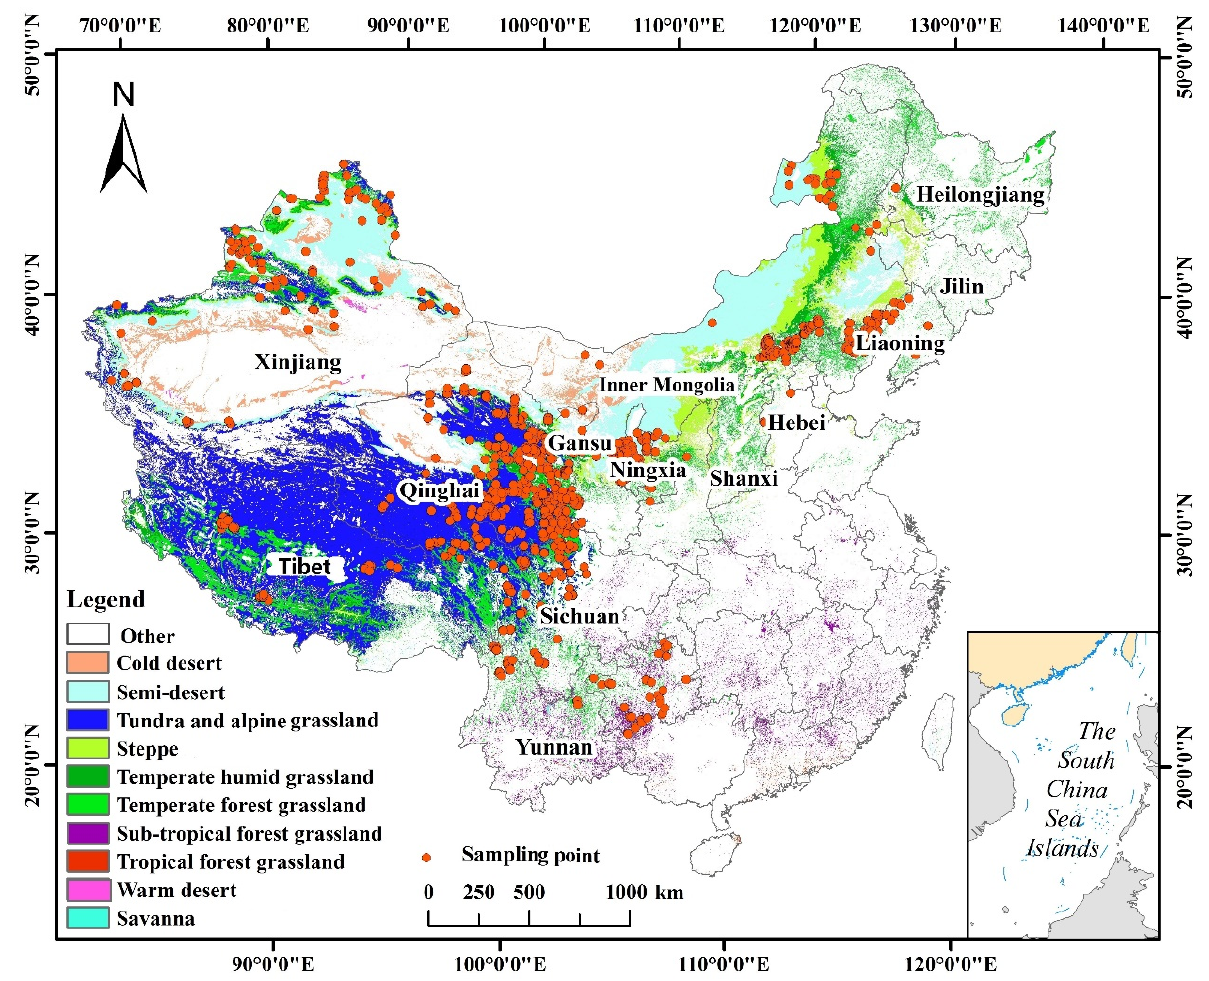
Figure 1. Space distribution of the actual grassland CSCS super-class groups in China and system sampling points. Note: The tundra and alpine grassland cover the largest area, accounting for 38.39% of the total grassland area, followed by semi-desert grassland, accounting for 19.91%, and Savanna grassland, which covers the smallest area, accounting for 0.09%.